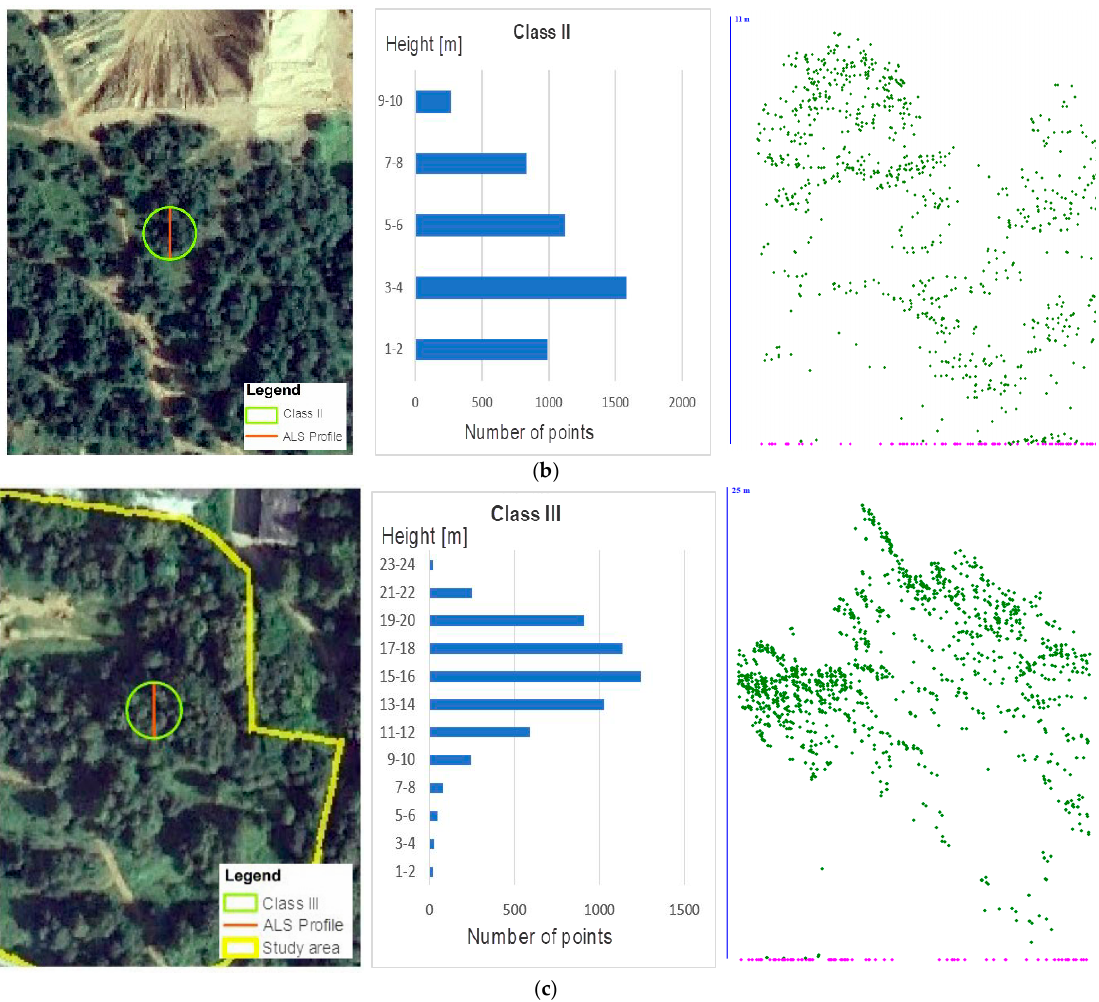
Figure 9. The vegetation classes—view of orthophotomap, histogram (number of points), and ALS point clouds profile: ( a ) low vegetation; ( b ) medium vegetation; ( c ) high vegetation.